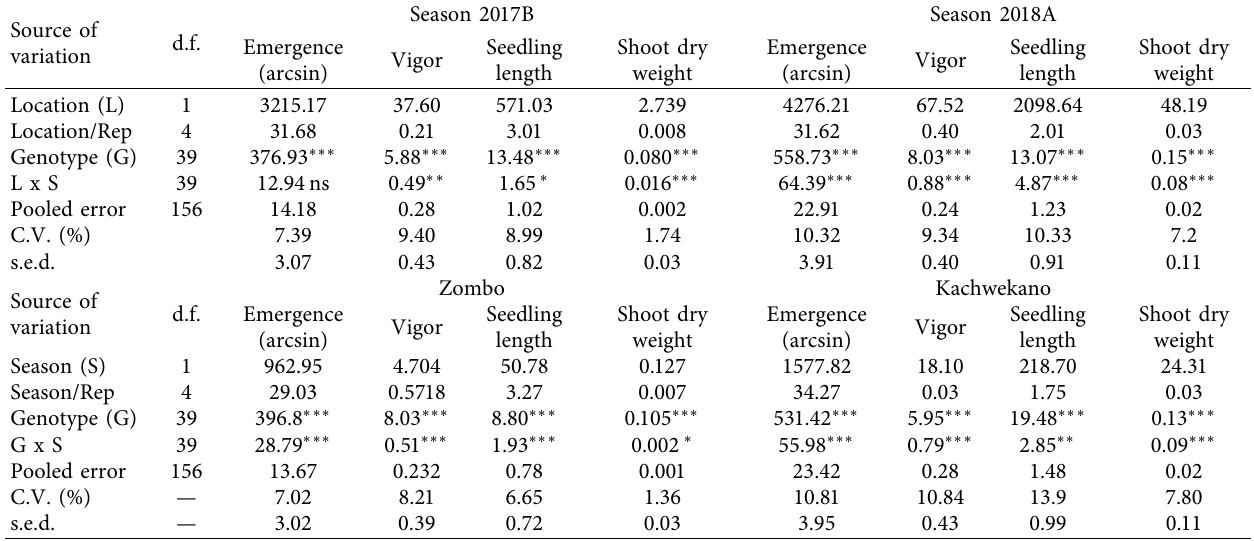
Table 4: Mean squares of field trials and their interactions, partitioned into seasons (2017B and 2018A) and locations (Kachwekano and Zombo).